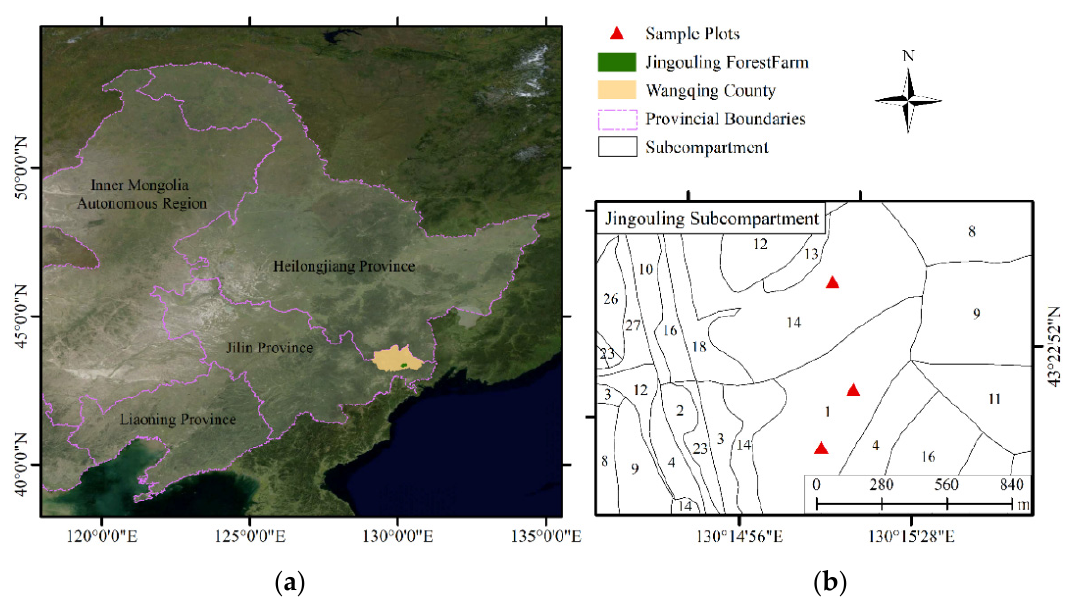
Figure 1. Location of the study area: Wangqing Forest Bureau ( a ) in northeast China and spatial distribution of 3 sample plots ( b ).